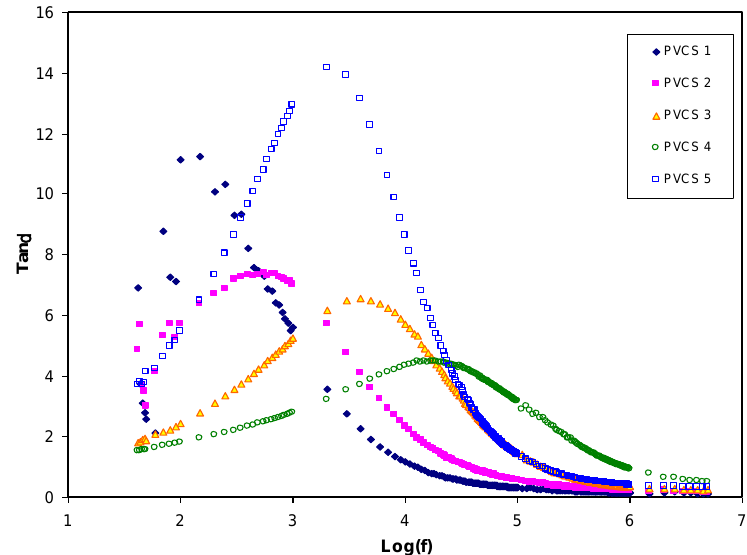
Figure 10. Tanδ versus log (f) for all polymer blend electrolytes. Figure 10. Tan δ versus log (f) for all polymer blend electrolytes.